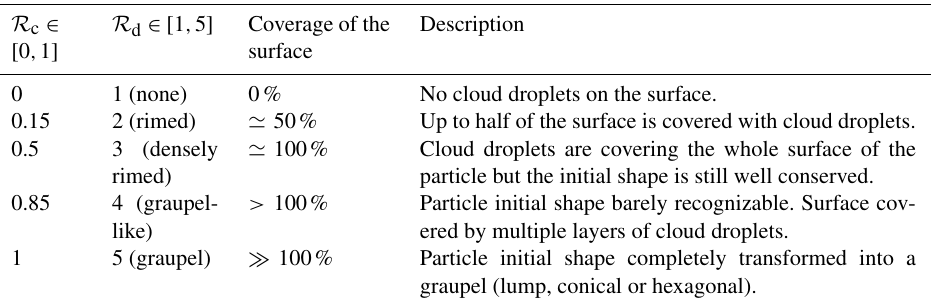
Table 1. Riming scale and qualitative description of each level. First column is the new riming index introduced in this study and second column its corresponding qualitative riming degree, adapted from Mosimann et al. (1994).